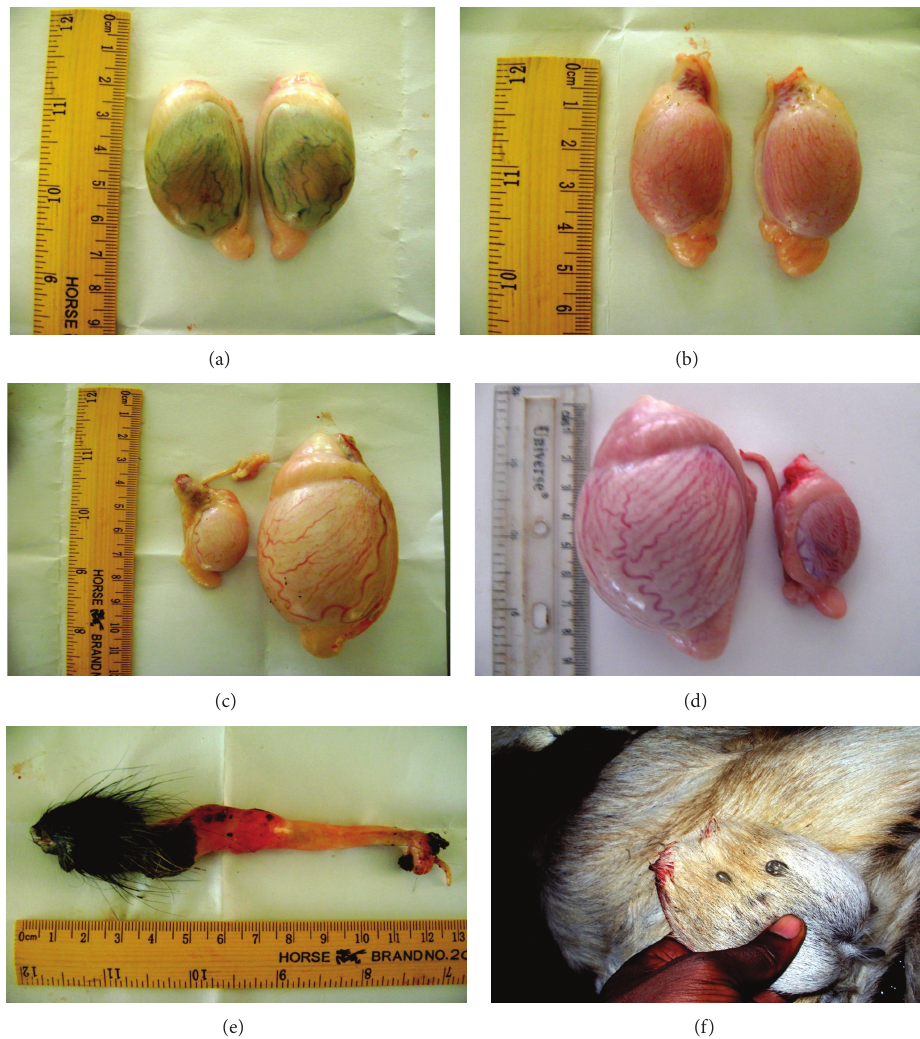
Figure 1: Male reproductive system of the Sahel goat showing (a) bilateral testicular atrophy, (b) bilateral testicular hypoplasia, (c) unilateral cryptorchidism, (d) unilateral testicular hypoplasia, (e) balanitis, and (f) ectoparasites (ticks) on the scrotal